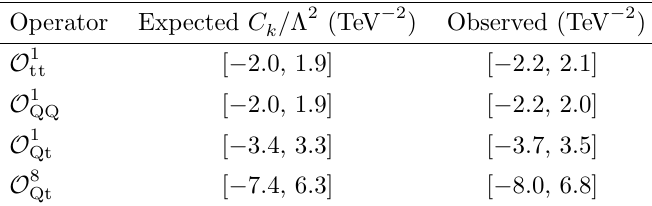
Table 6 . Expected and observed 95% CL intervals for selected coupling parameters when contri- bution of other operators is